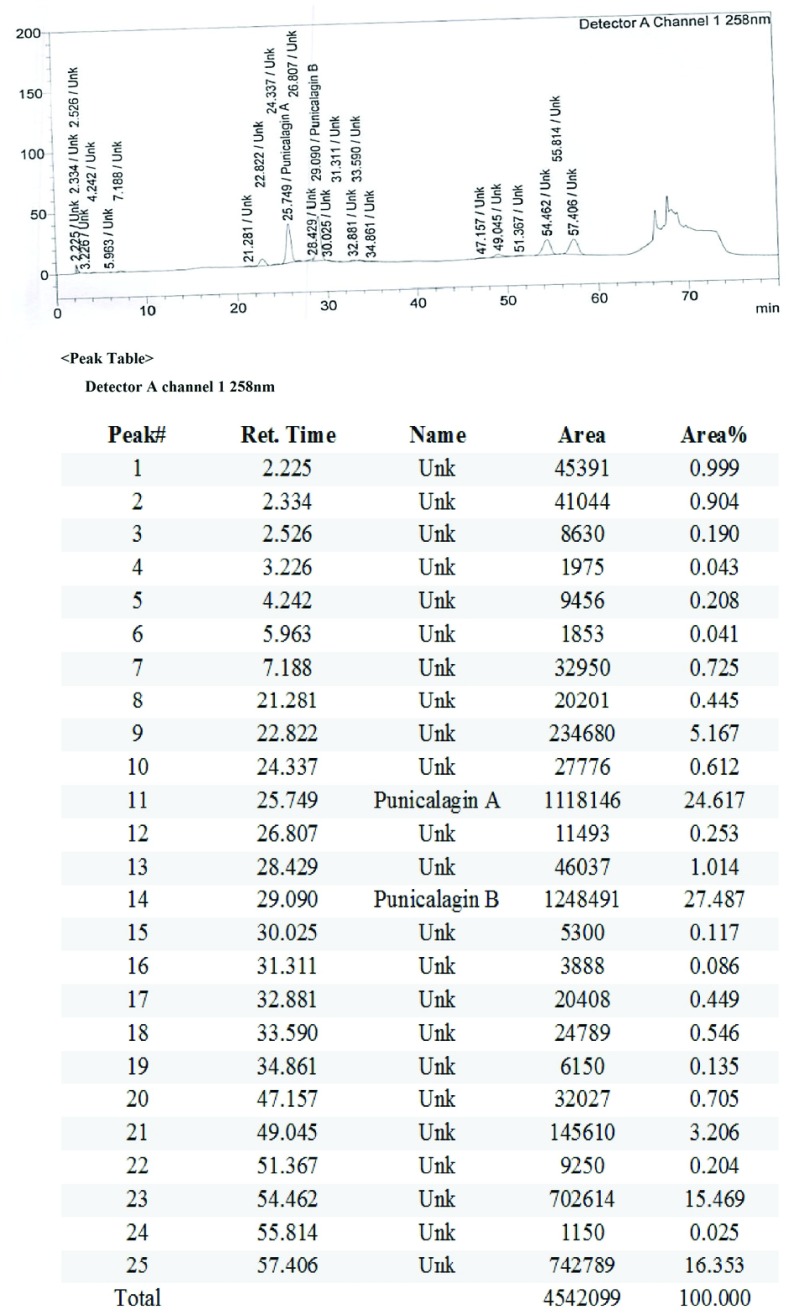
HPLC profile of PGPE.Peak 11 and 14 occupied 24.61% and 27.48% of total area, which corresponds to Punicalagin A and B, respectively. PGPE,
Punica granatum peel extract.